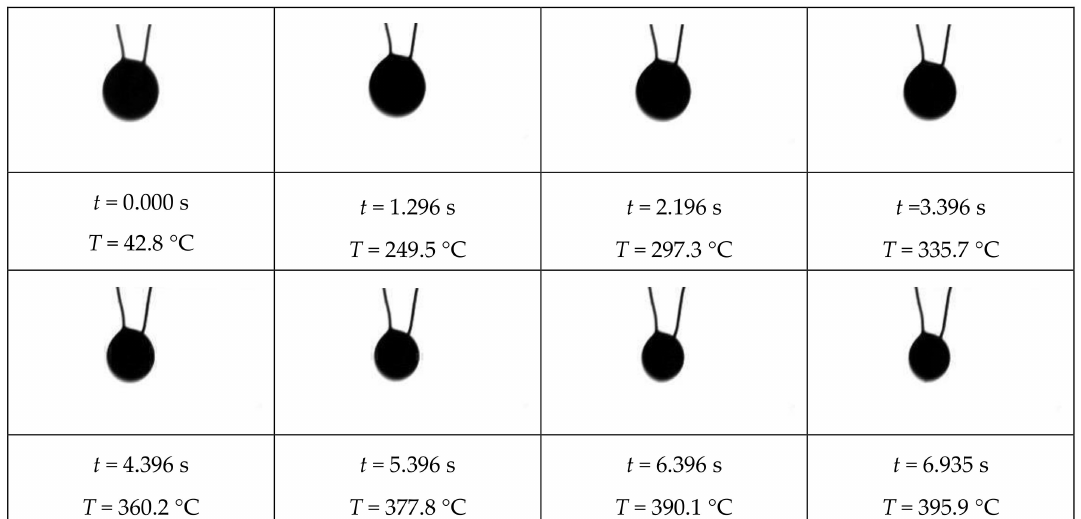
Figure 4. The images of evaporation characteristics and shape change with heating time of a pure HFO droplet with an initial diameter d 0 = 1.04 mm at 400 ◦ C environment. T represents the instantaneous temperature at the time of obtaining each image.